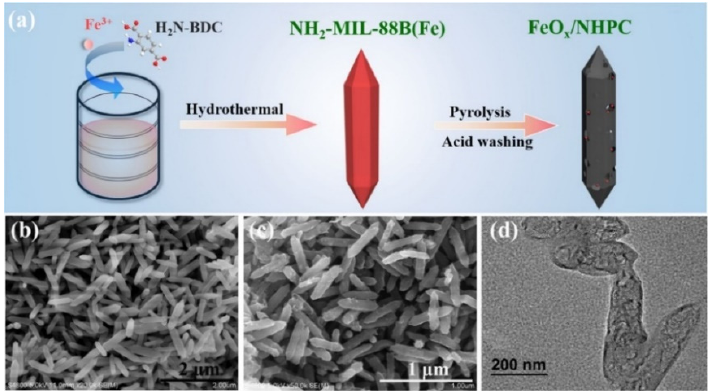
Figure 9. ( a ) Scheme of the fabrication process for FeOx/NHPC; ( b ) SEM image of NH2-MIL-88B(Fe); ( c ) scanning and ( d ) transmission electron microscopy images of FeOx/NHPC750